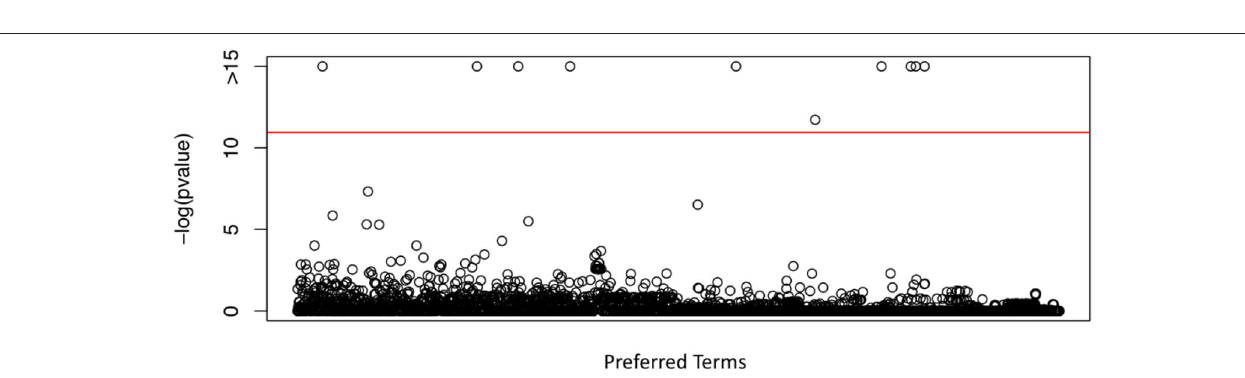
census data to investigate the differential risk of experiencing AEs after vaccination in different race/ethnicity groups. By